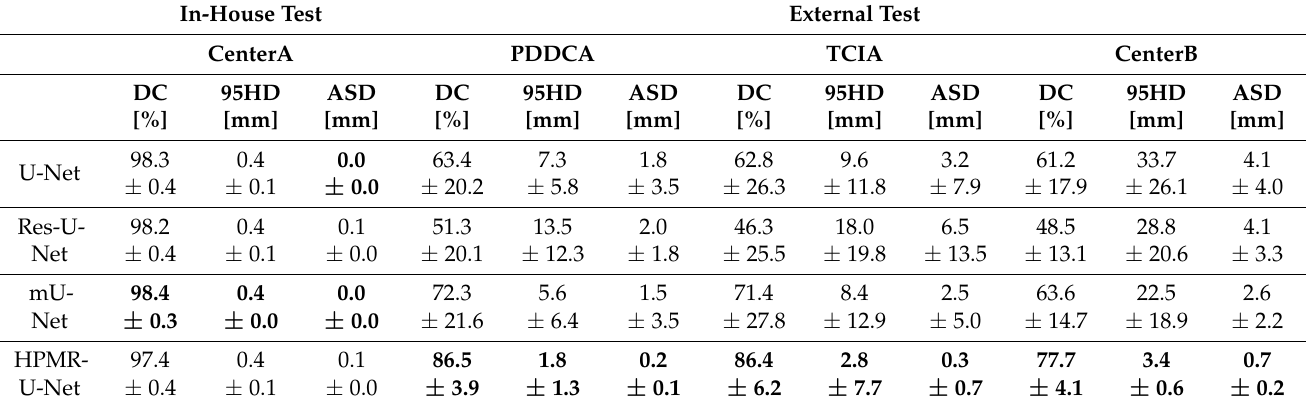
Table 2. Results of in-house and external tests for mandible segmentation. The best case is